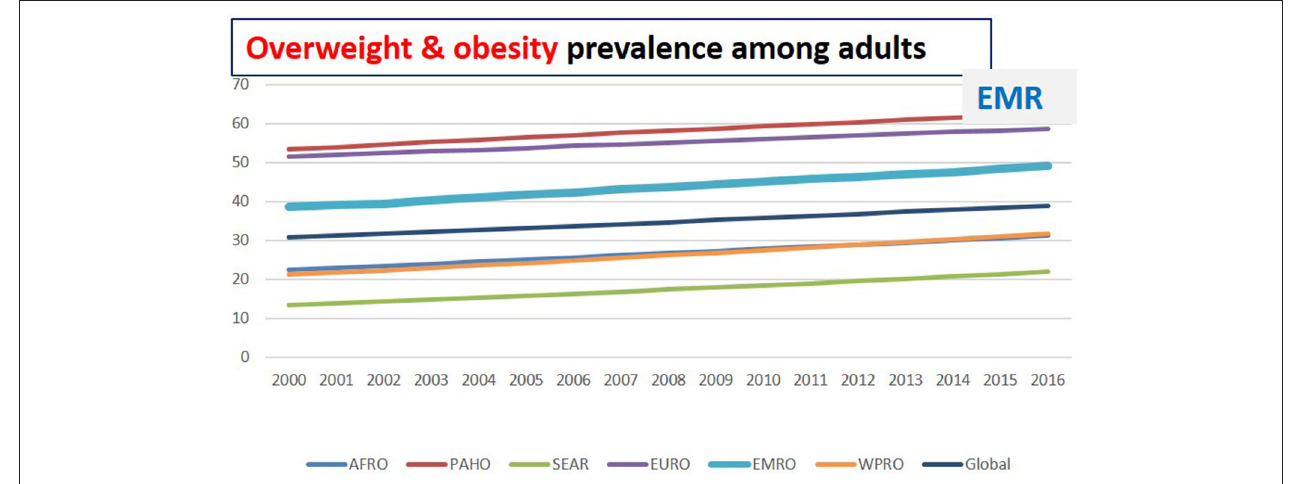
FIGURE 3 | Overweight and obesity prevalence among adults in different regions